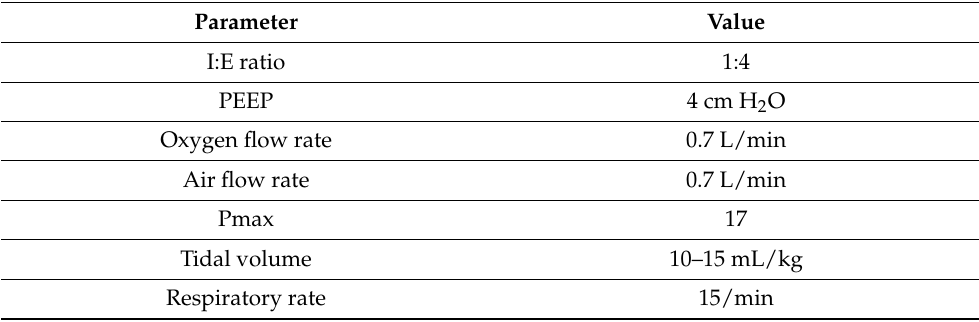
Table 1. Overview of all major respiratory setting during volume controlled mechanical